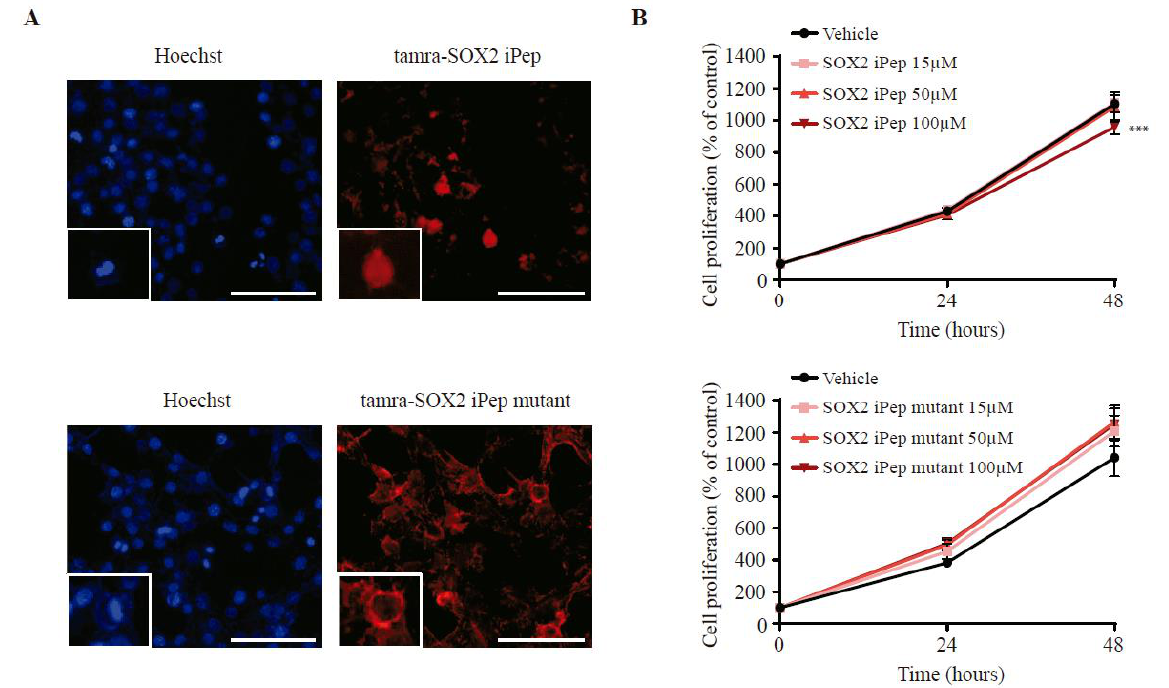
Figure 4. ( A ) Representative fluorescence images of T11 cells treated with 20 µM of SOX2 iPep conjugated with TAMRA (TAMRA-CKRLRALH-Nle-KEHPDYKYRPRRKTKT-NH 2 ), and SOX2 iPep mutant conjugated with TAMRA for 2 h. Bars represent 100 µm. ( B ) Cell proliferation plot of T11 cells treated with 15 µM, 50 µM, and 100 µM of SOX2 iPep and SOX2 iPep mutant for 24 and 48 h. Treatment conditions were compared statistically to the vehicle control using a two-way ANOVA test. ns means not significant, *** means p < 0.0005.